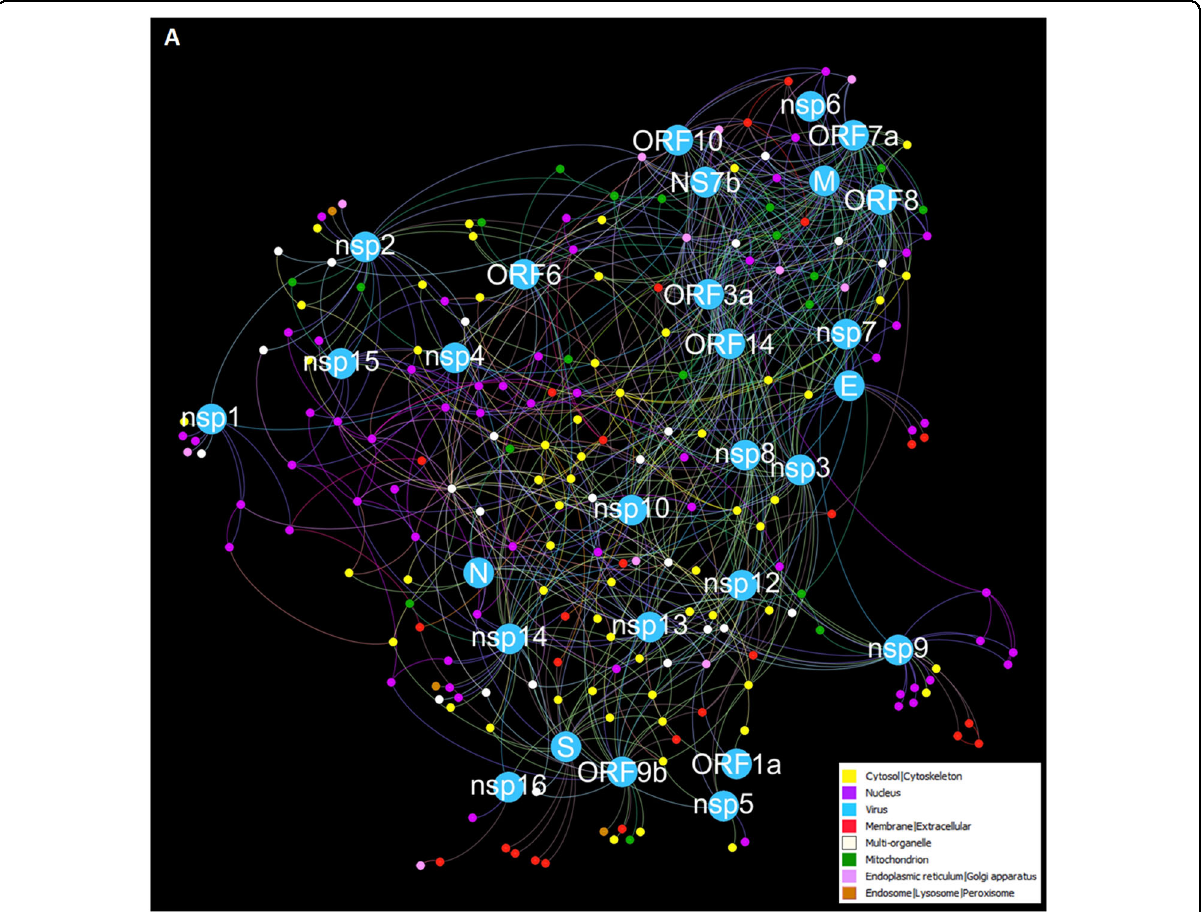
Fig. 2 PPI interactome, based on human PPI and SARS-CoV-2-host interactions, with top 200 closest proteins identi fi ed by RWR, using together 28 proteins of SARS-CoV-2 as seeds for only one RWR run. Different colours of node and edges represent different locations in the cell, which are reported in the legend and in Supplementary Table 1. This network was represented by Force Atlas